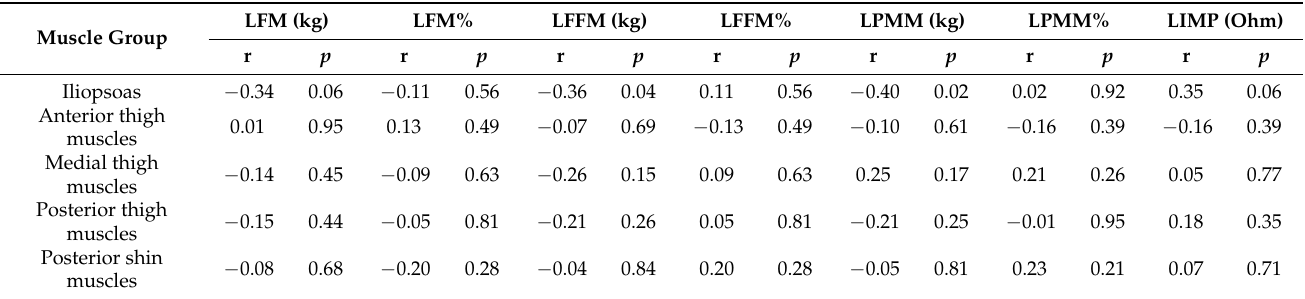
Table 8. Spearman correlations between the mass composition of the affected lower limbs and the spasticity of individual muscle groups of the affected lower limbs in the tested group (n =